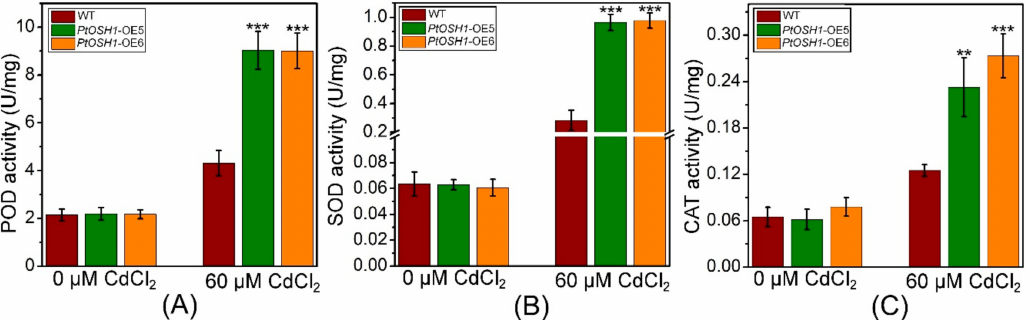
Figure 8. Activities of POD ( A ), SOD ( B ), and CAT ( C ) in WT and PtOSH1 -OE A. thaliana lines before and after exposure to 60 µ M Cd 2 + . Three independent biological experiments were performed with three technical repeats. One-way ANOVA and Tukey’s test were used to evaluate significant di ff erences. Vertical bars represent the means ± SD ( n = 3). **, Significant di ff erence at p < 0.01; ***, significant di ff erence at p <